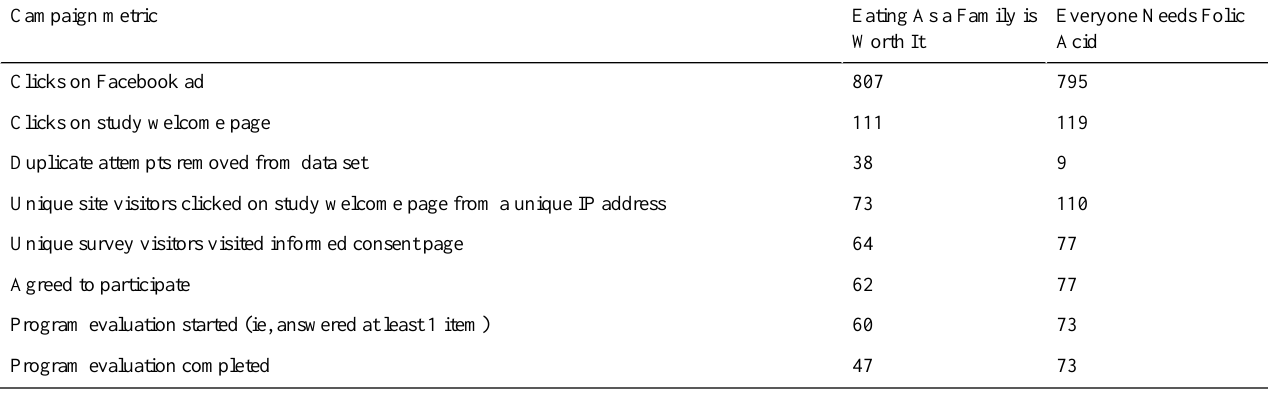
Table 3. Facebook campaign response